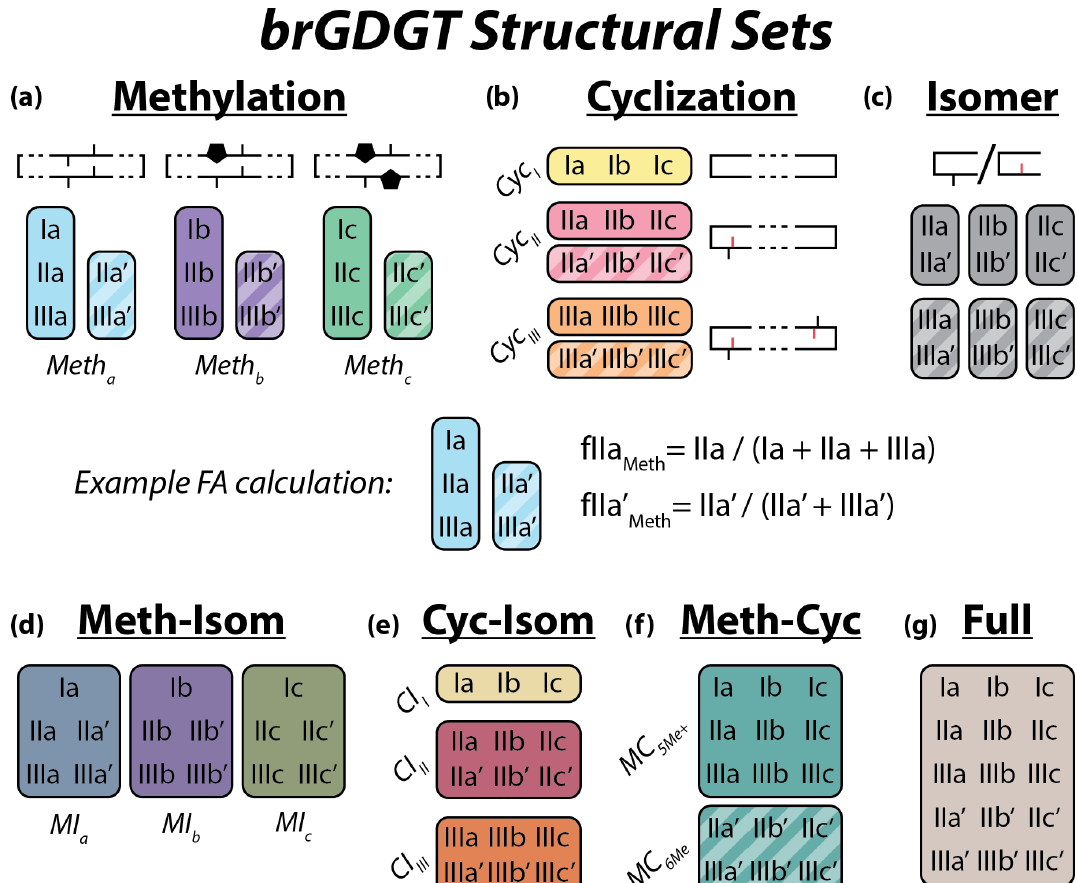
Figure 2. Schematic of the basic (a–c) and combined (d–g) brGDGT structural sets. Fractional abundances are calculated within each boxed group independently (Eqs. 3–9 and Table A1). Schematic structures highlight the defining alkyl-chain moieties, with cyclopentane rings filled in for emphasis and C6 methylations denoted in red. Complete structures are available in Fig.